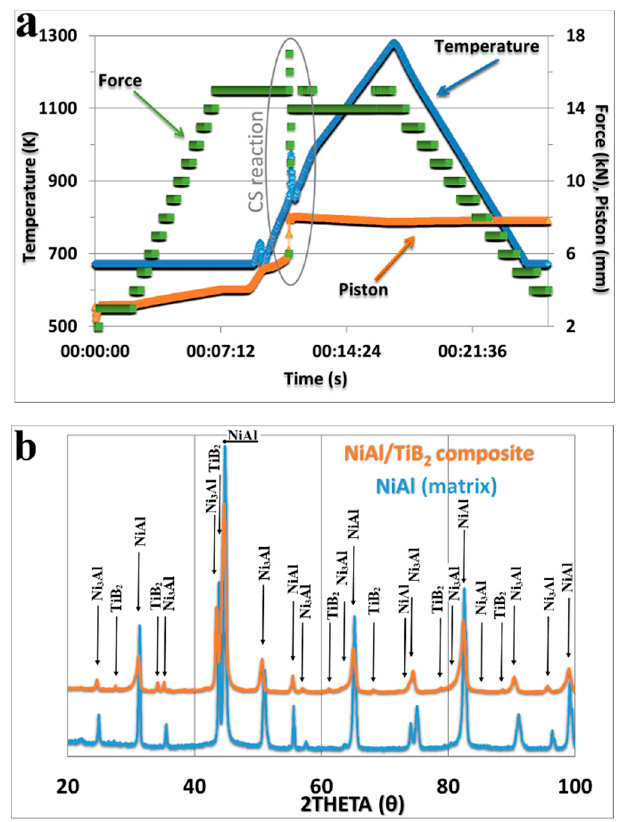
Figure 2. ( a ) Diagram of the course of the NiAl alloy (matrix material) sintering process, ( b ) the results of XRD analysis of both matrix material and composite.